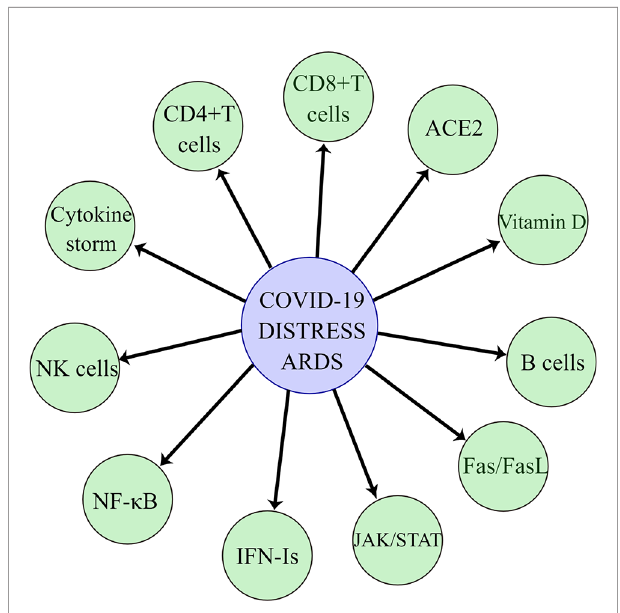
FIGURE 1 | SARS-CoV-2 causes acute respiratory distress syndrome through angiotensin-converting enzyme 2, cytokine storm, immune cells, Fas/ FasL pathway, JAK/STAT pathway, NF- k B pathway, type I interferon, and vitamin